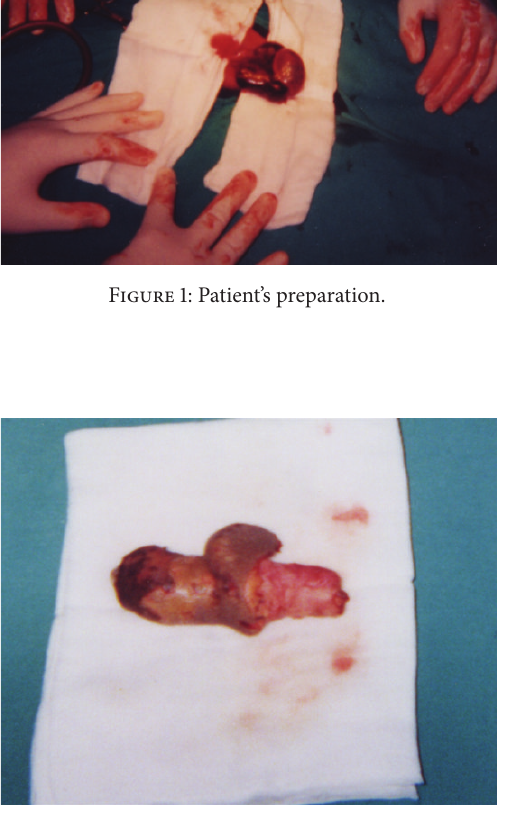
Figure 2: Penile ventral